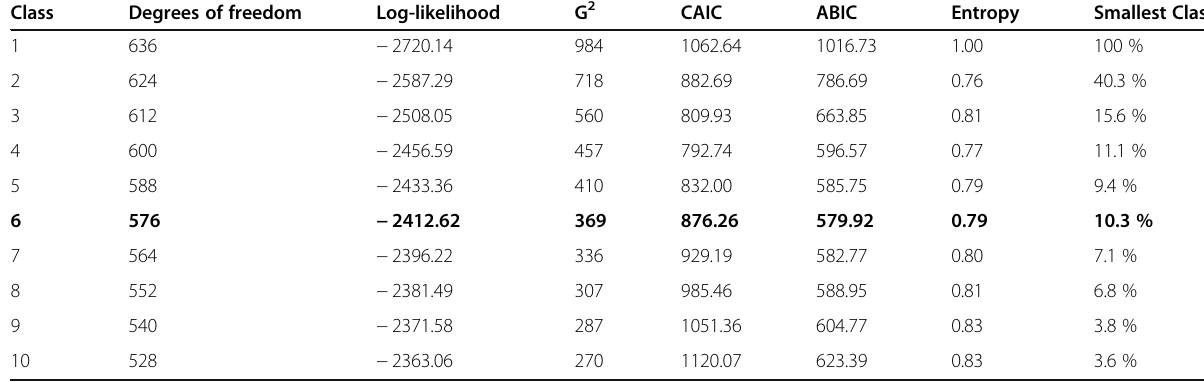
Table 2 Evaluation criteria for determining the number of classes of the LCA